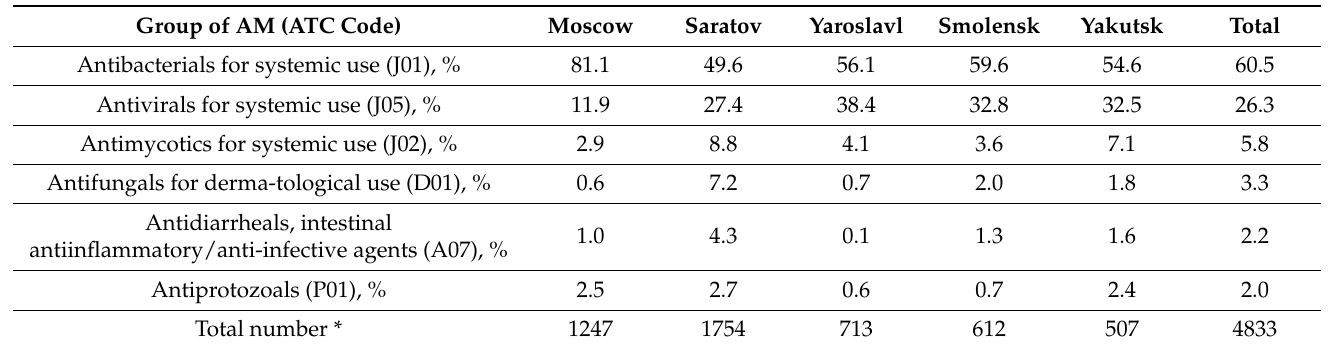
Table 4. Groups of AM agents supplied in community pharmacies.